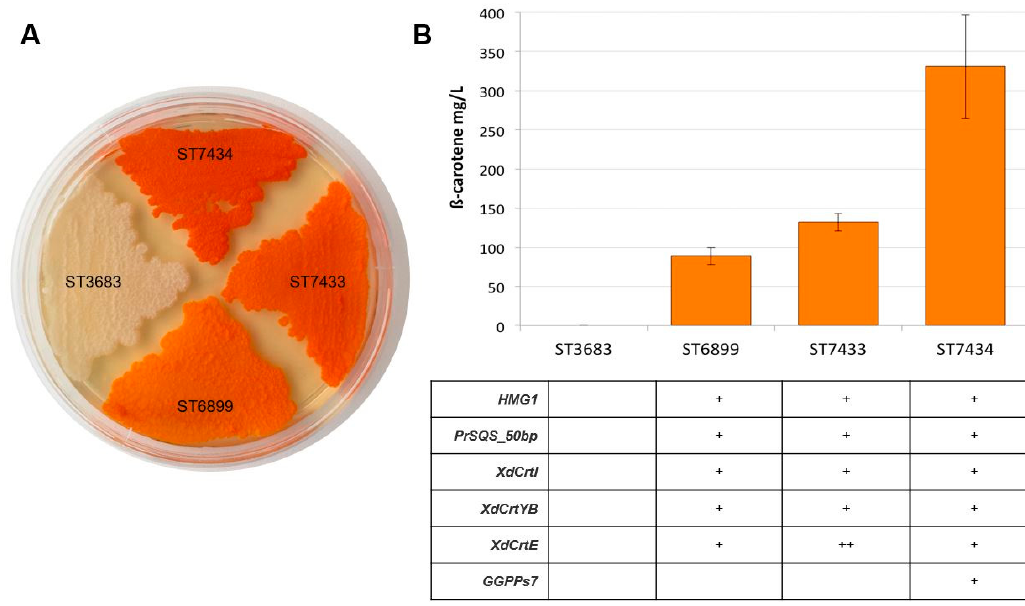
Figure 1. E ff ect of Synechococcus GGPPs7 (ST7434) and the 2 nd copy of crtE (ST7433) on β -carotene production. ST6899 is the parental strain to ST7434 and ST7433. ( A ) Yeast extract peptone dextrose (YPD) plate after 2 days cultivation. ( B ) Titers measured by HPLC. The error bars represent standard deviations calculated from biological triplicate